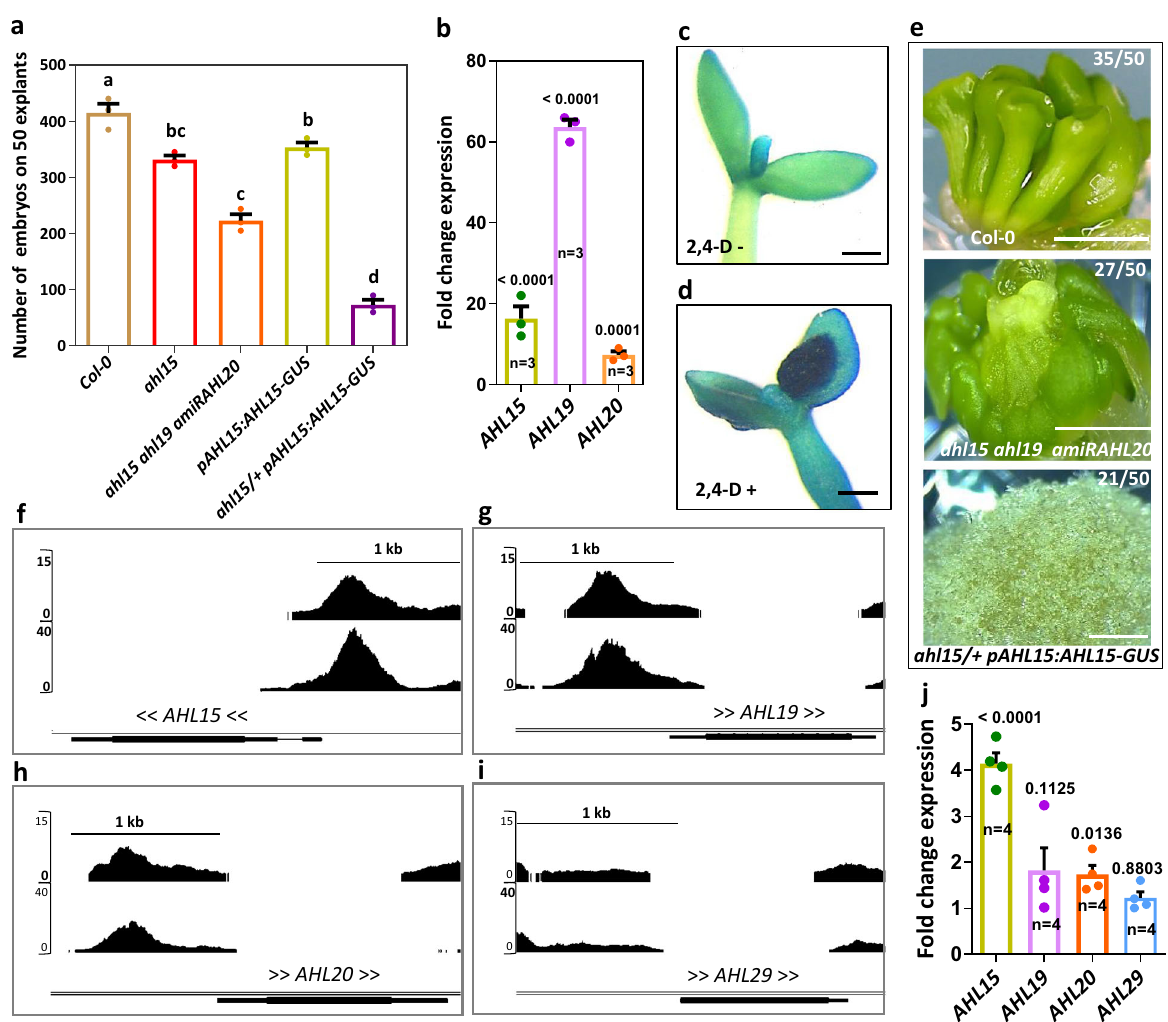
Fig. 3 AHL genes are essential for 2,4-D-induced and BBM-induced SE. a The effect of ahl loss-of-function on the capacity to induce somatic embryos on IZEs by 2,4 – D. Dots indicate the values of three biological replicates per plant line with 50 IZEs per replicate, bar indicates the mean, and error bars the s.e. m. For the ahl15/ + pAHL15:AHL15-GUS combination IZEs were harvested from ahl15/ + pAHL15:AHL15-GUS plants and scored and genotyped after culture. Only scores of ahl15/ + pAHL15:AHL15-GUS explants were used. The letters indicate statistically different values, as determined by a one-way ANOVA with Tukey ’ s post hoc test. The p -values are provided in the source data fi le. b RT-qPCR analysis of the fold change in expression of AHL15 , AHL19 and AHL20 in IZEs cultured for 7 days on medium with 5 μ M 2,4-D relative to medium without 2,4-D. c , d pAHL15:AHL15-GUS IZEs cultured for 7 days in the absence ( c ) or presence ( d ) of 5 μ M 2,4-D and histochemically stained for GUS activity. Similar results were obtained from two independent experiments. Size bar indicates 1 mm. e Predominant phenotype of wild-type (upper panel), ahl15 ahl19 amiRAHL20 (middle panel), or ahl15/ + pAHL15:AHL15-GUS (lower panel) IZEs cultured for 2 weeks on 2,4-D medium. Numbers indicate the frequency with which similar phenotypes were observed in two independent experiments. Size bar indicates 1 mm. f – i ChIP-seq BBM binding pro fi les for AHL15 ( f ), AHL19 ( g ), AHL20 ( h ), and AHL29 ( i ). The binding pro fi les from the pBBM:BBM-YFP (upper pro fi le) and p35S:BBM-GFP (lower pro fi le) ChIP-seq experiments are shown. The x -axis shows the position of DNA binding relative to the location of the selected gene (TAIR 10 annotation), the y -axis shows the ChIP-seq score (fold enrichment of the BBM-GFP/YFP ChIP to the control ChIP), and the arrow brackets around the gene name indicate the direction of gene transcription. j RT-qPCR analysis of the fold change in expression of AHL genes in DEX + CHX treated p35S:BBM-GR seedlings relative to that in DEX + CHX treated Col-0 wild-type seedlings. b , j Dots indicate the values of three or four biological replicates, bar indicates the mean, and error bars the s.e.m. The p -values were determined by a two-sided Student ’ s t protodermal cells of 35S:AHL15 IZEs after 7 days of culture